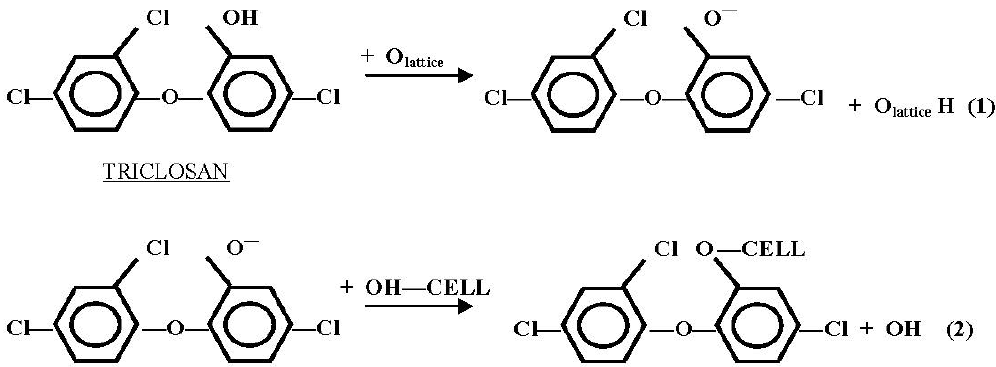
Figure 3. Catalytic reaction between cellulose and triclosan